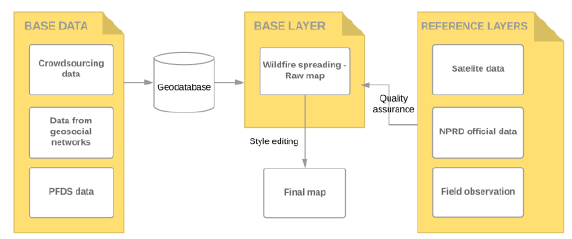
Figure 6. Methodology workflow for aggregating data from different sources